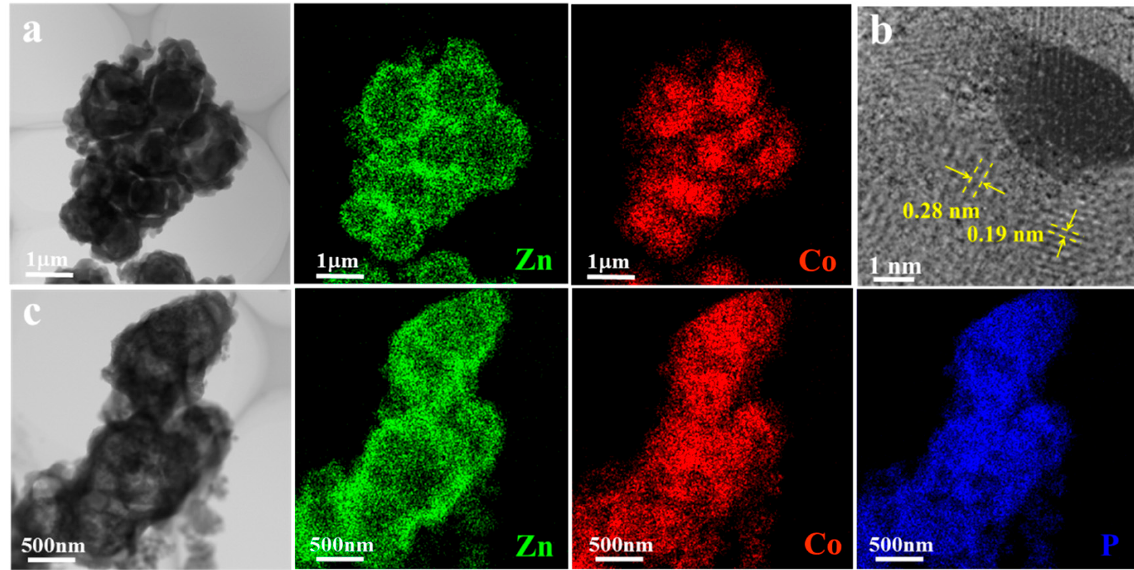
Figure 6. ( a ) TEM-EDS mapping of the ZIF-67@ZIF-8 of Zn, Co. ( b ) HRTEM image of the CoP@ZIF-8. ( c ) TEM-EDS mapping of the CoP@ZIF-8 of Zn, Co, P.